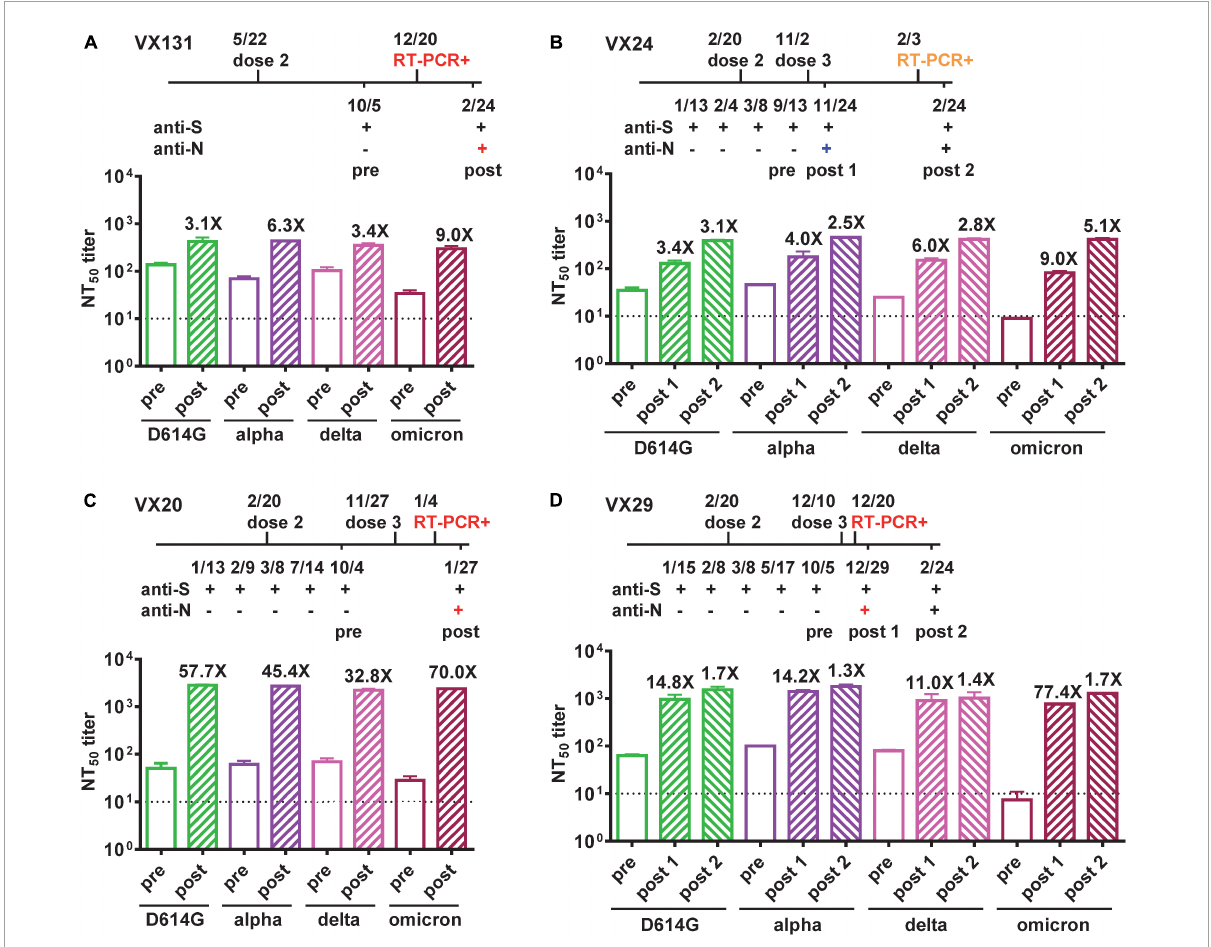
FIGURE2 Neutralizing antibodies against VOC before and after BTIs. (A–D) Time course of vaccination, anti-N and anti-S ELISAs, and RT-PCR test of four COVID-19-naïve participants (VX131, VX24, VX20, VX29) who received two or three doses of Moderna vaccine with a BTI identified by anti-N antibody seroconversion. Symptomatic BTIs with positive RT-PCR test and anti-N ELISA are shown in red, asymptomatic BTI with positive anti-N ELISA in blue, and symptomatic reinfection with positive RT-PCR test in orange. NT 50 titers against D614G, Alpha, Delta and Omicron variants before (pre, open bars) and after (post, hatched bars) BTIs were determined by pseudovirus neutralization test (28). Number x = fold increase in NT 50 titers compared with previous time point. Dotted lines indicate NT 50 titer = 10. Data are the means and standard deviations of duplicates from one experiment.